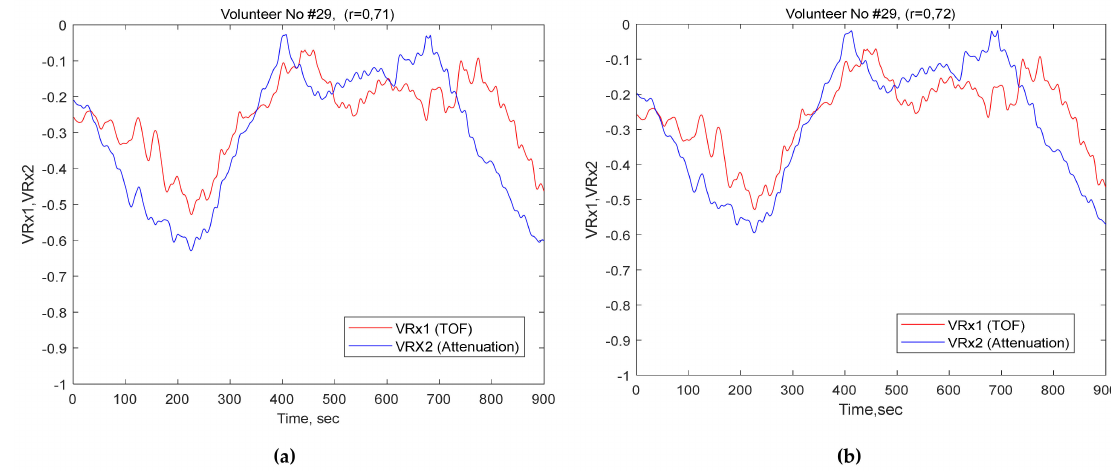
Figure 5. Comparison window for volumetric reactivity indices (VRx 1 and VRx2) for15 minute time with ( a ) an excellent correlation by the bandpass filter and ( b ) excellent correlation by the FIR filter. Three minute time-averaged (per participant in 43 pairs) VRx1 and VRx2 indices were used for linear regression, where the correlation coe ffi cient between VRx1 and VRx2 averaged 0.731, with a 95% confidence interval of 0.501–0.895 and a statistical significance of less than 0.0001 in the studied population. Similarly, in FIR filtered data, the correlation coe ffi cient between VRx1 and VRx2 averaged 0.769, with a 95% confidence interval of 0.611–0.909 and a statistical significance of less than 0.0001 in the studied population (see Figure